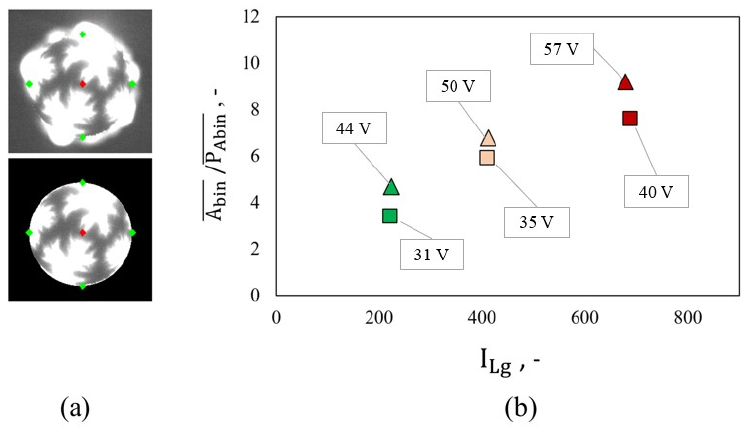
Figure 12. ( a ) Igniter discharge image cropping for streamers binarized area and perimeter estimation; ( b ) Discharge aspect ratio as a function of the integral luminosity in pure N 2 (square markers) and synthetic air (triangular markers). Same color markers (green, orange, red) represent discharge events with equivalent luminosity among the two media.